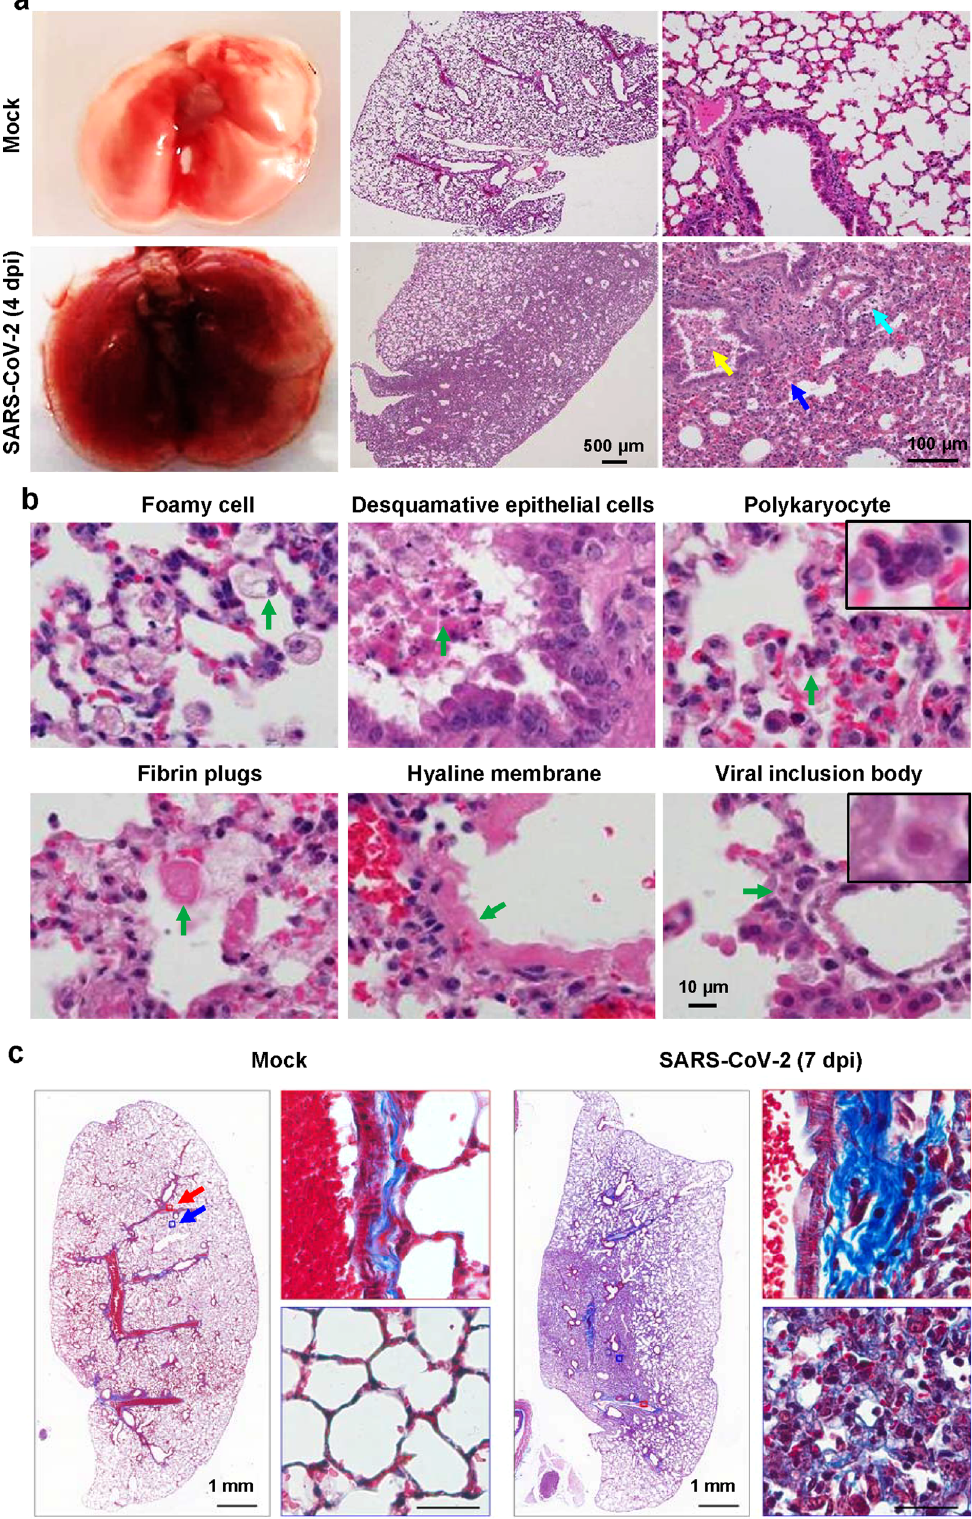
Fig. 3 Acute lung damage caused by MASCp36 infection in mice. a Gross necropsy and hematoxylin and eosin (H&E) staining of lung sections from male BALB/c mice (9-month-old) infected with 1200 PFU of MASCp36. Yellow arrow indicates desquamative epithelial cells in bronchiole tubes, cyan arrow indicates edema around vessels, and blue arrow indicates hemorrhage. Representative images are shown ( n = 3 per group). b Microscopic observation of lungs showing foamy cells, desquamative epithelial cells, polykaryocytes, fi brin plugs, hyaline membrane, and viral inclusion body ( n = 3 per group). c Masson ’ s trichrome staining of lung sections from male BALB/c mice (9-month-old) infected with 120 PFU of MASCp36 ( n = 5 per group) at 7 dpi. Framed areas are shown adjacently at higher magni fi